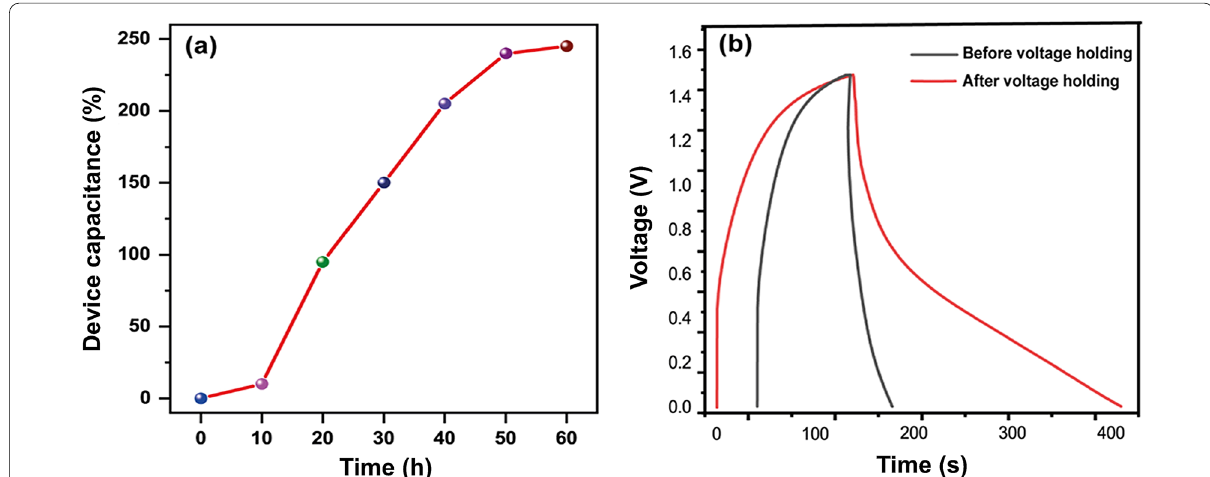
Fig. 6 a Voltage holding with respect to device capacitance (%) at a current density of 2 A g − 1 . b GCD curves of a symmetric device with MnO x / C-rGO before and after voltage holding test at 2 A g − 1 in 1.0 M Na 2 SO 4 solution